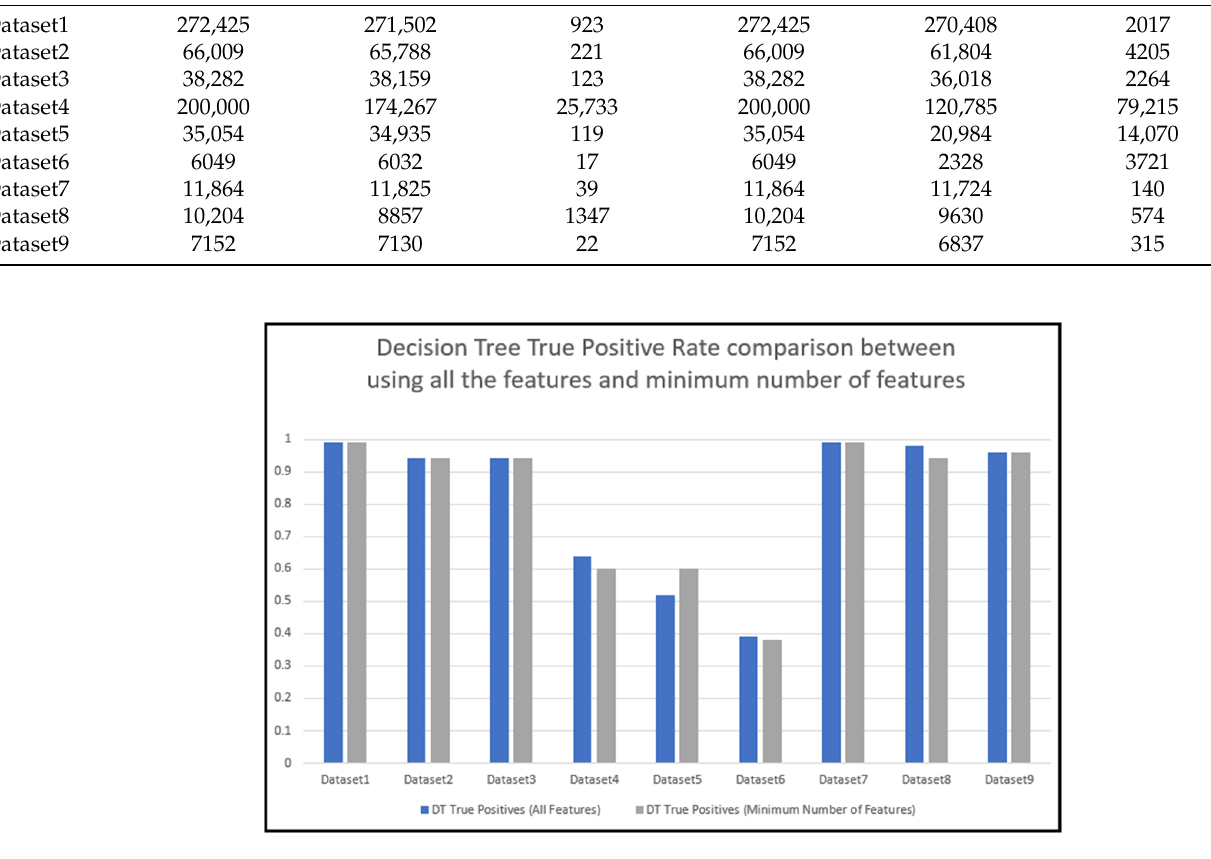
Figure 11. DT Zeus prediction results compared between using the minimum number of features and all the features in Feature set1.